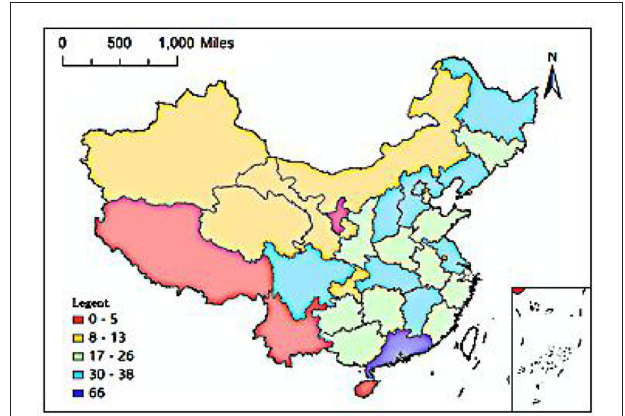
FIGURE 1 | Spatial distribution of provincial unit scale.